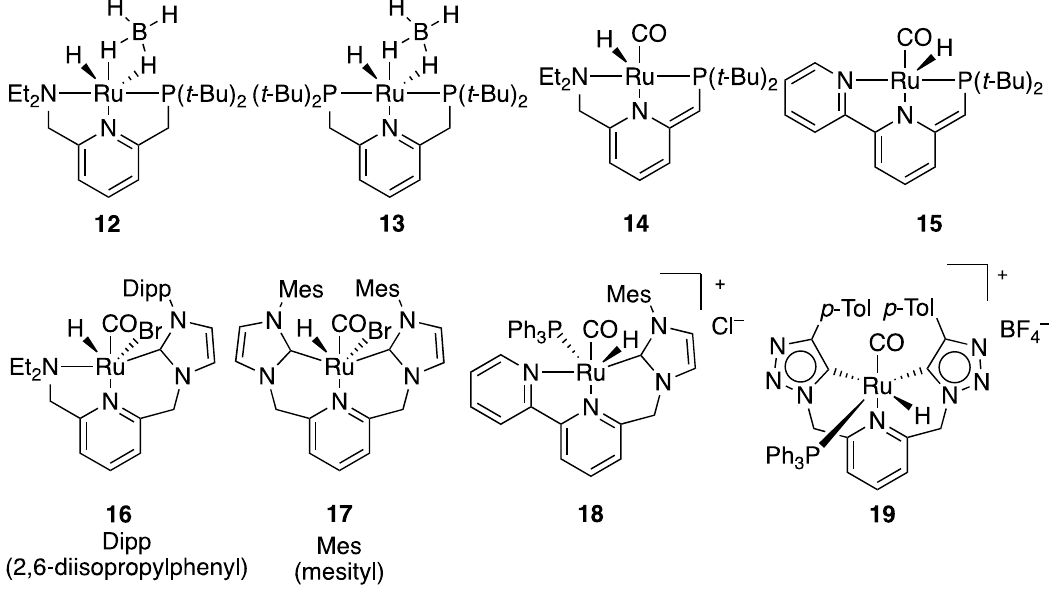
Figure 2. Ru-pincer complexes for the catalytic hydrogenation of esters.